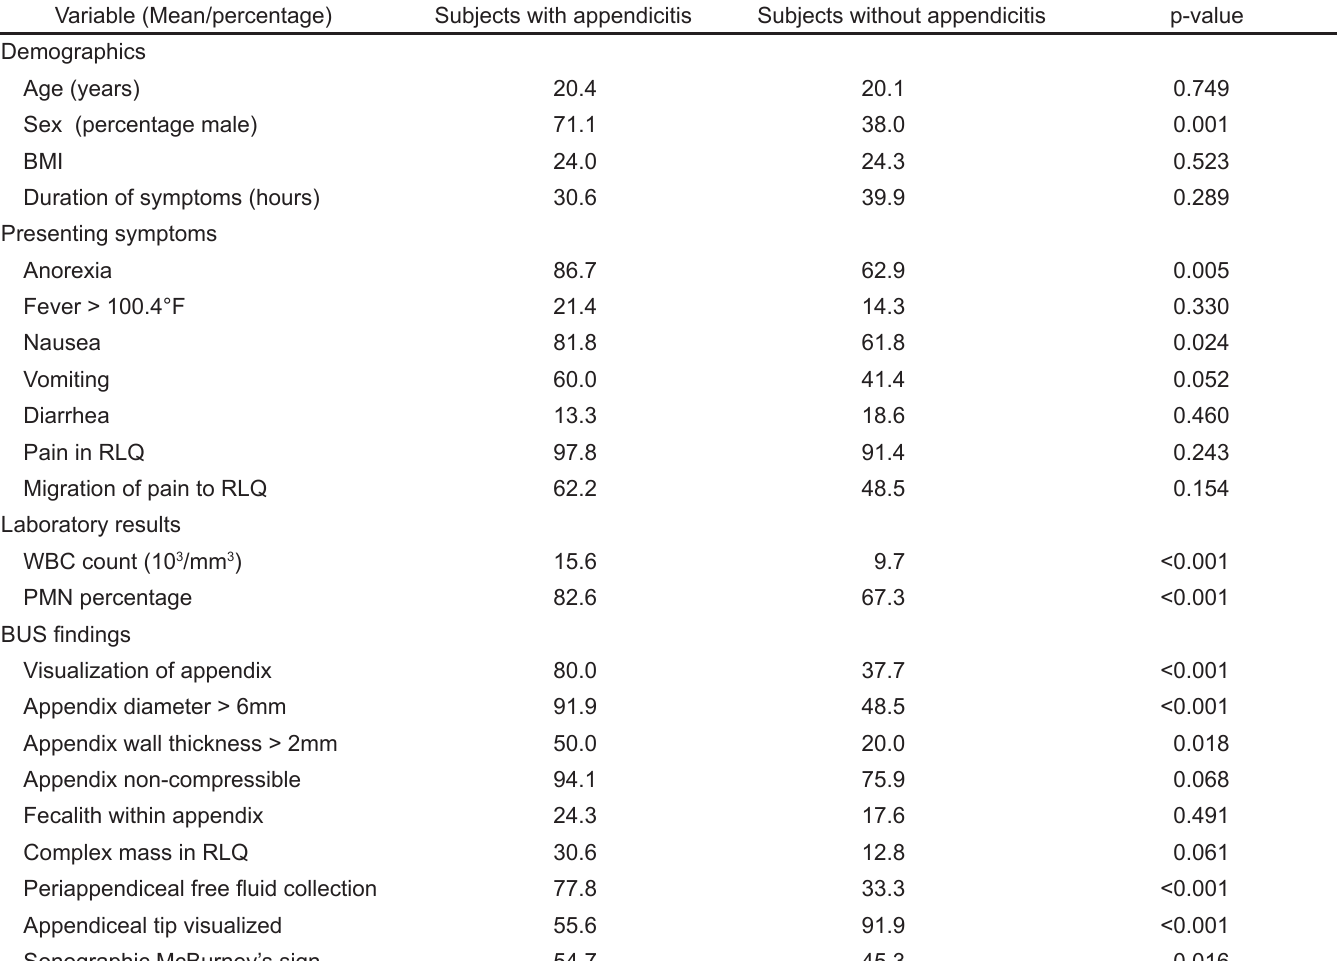
Table 4. Univariate analysis of demographic, history, laboratory and bedside ultrasound (BUS) characteristics of subjects with and without appendicitis.